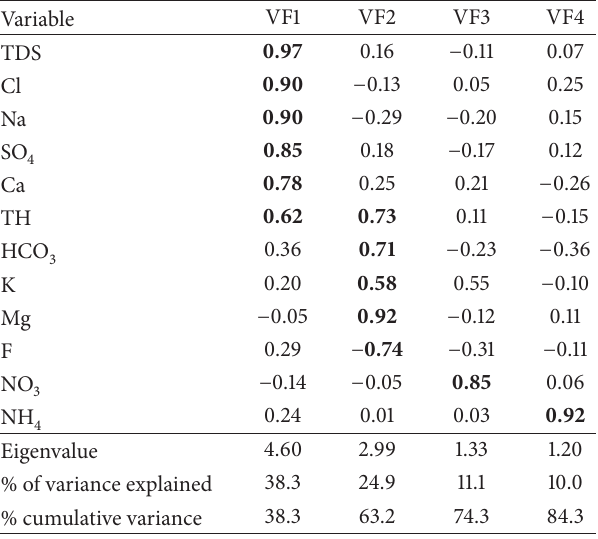
Table 4: Loadings of variables on 4 significant varifactors (VFs) of water quality